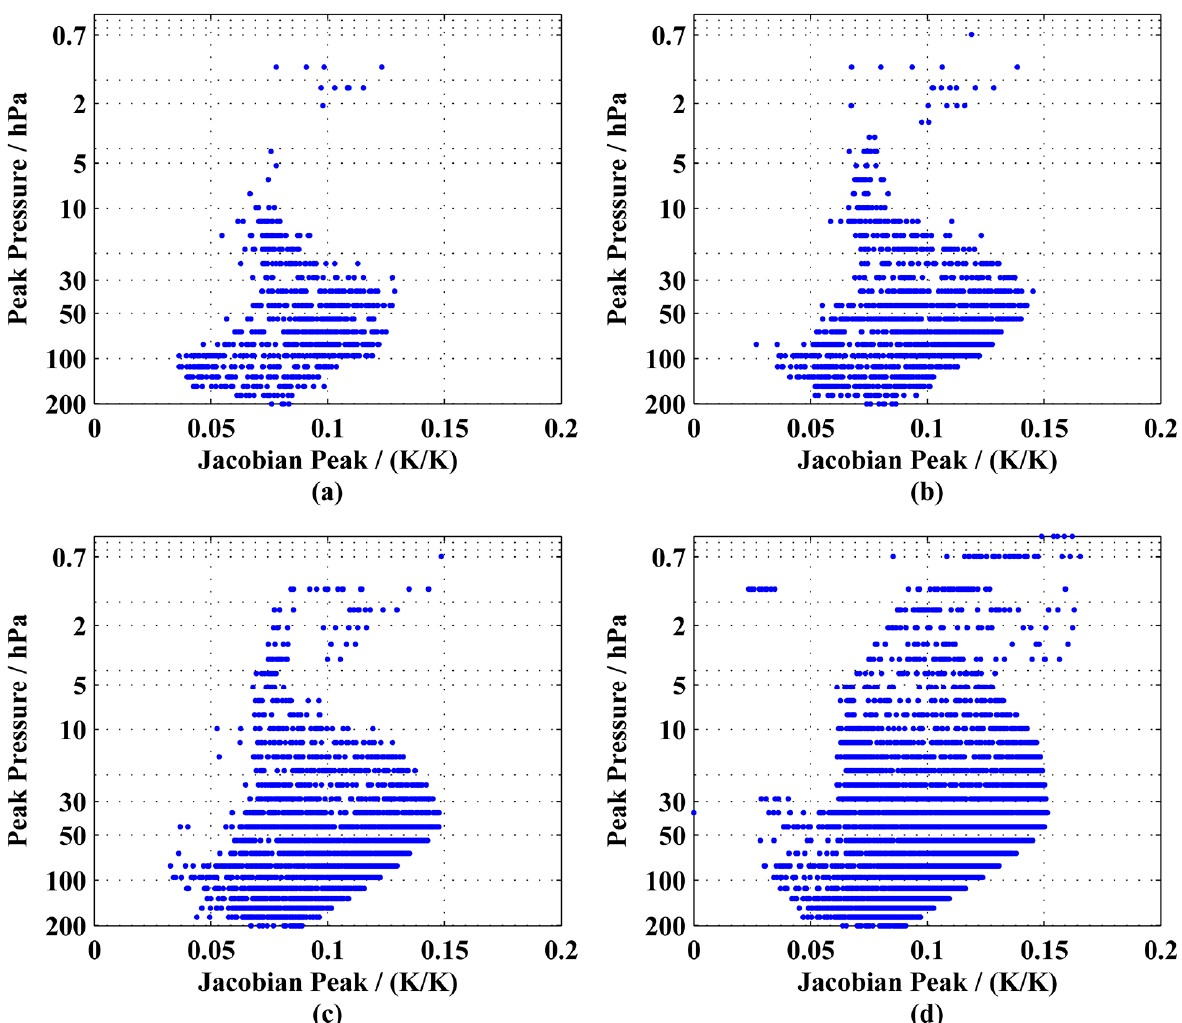
Figure 4. The temperature Jacobian peak corresponding to atmospheric pressure with different spectral resolutions and the same spectral region of 600–800 cm − 1 . ( a ) A spectral resolution of 0.1 cm − 1 . ( b ) A spectral resolution of 0.05 cm − 1 . ( c ) A spectral resolution of 0.03 cm − 1 . ( d ) A spectral resolution of 0.01 cm − 1 .